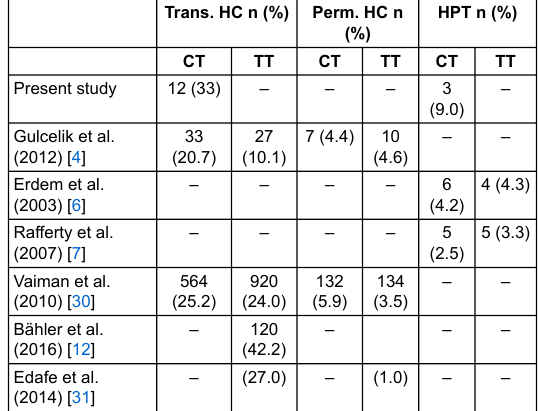
Table 3: Comparison of studies investigating completion thyroidecto- my (CT) and primary total thyroidectomy (TT) referred to transient and permanent hypocalcaemia-rates (trans. HC, perm. HC) as well as hy- poparathyroidism (HPT). Note that there is no internationally accepted definition for trans. and perm. HC and also for